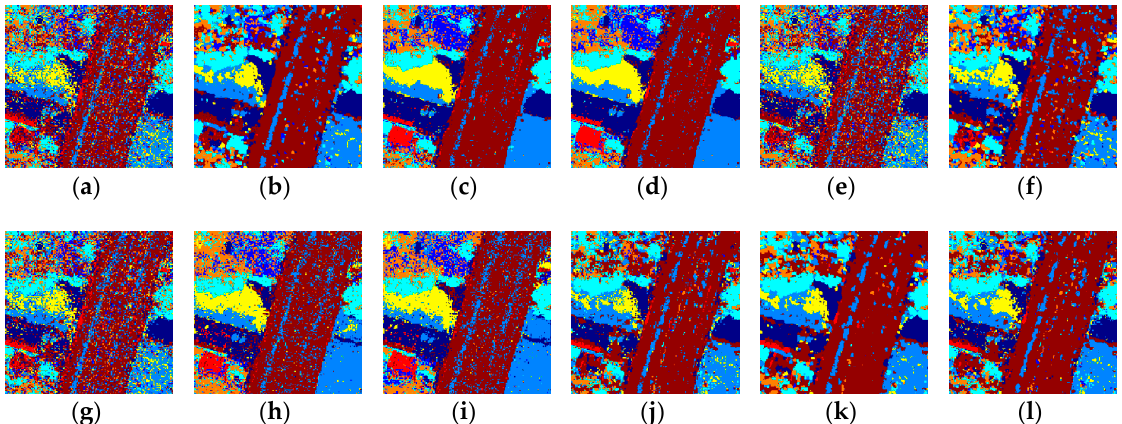
Figure 7. Classification results on the Ikonos-2 image obtained by using the ( a ) k-NN, ( b ) k-NN-WH-MV, ( c ) k-NN-SRM, ( d ) k-NN-SRM-IC, ( e ) OPF, ( f ) OPF-WH-MV, ( g ) OPF-MRF, ( h )